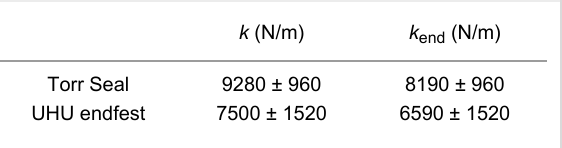
Table 1: Spring constants measured by Hooke’s law. k refers to the position at which the load is applied, while k end is obtained by extrapo- lation for the end of the free prong.